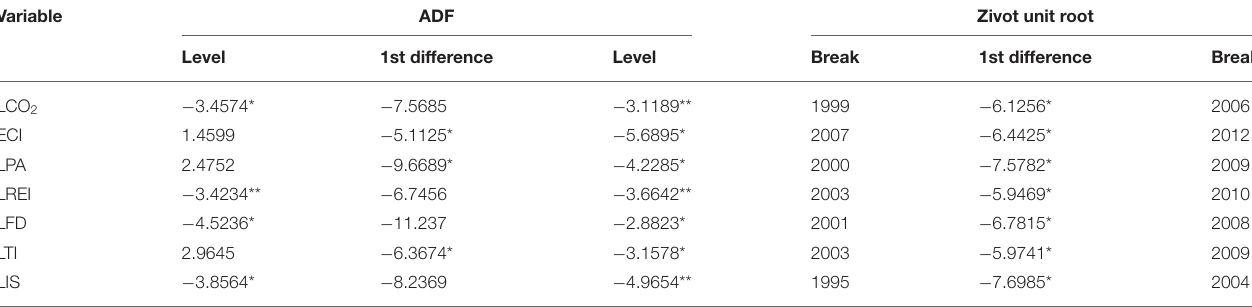
TABLE 6 | Unit root tests. Variable